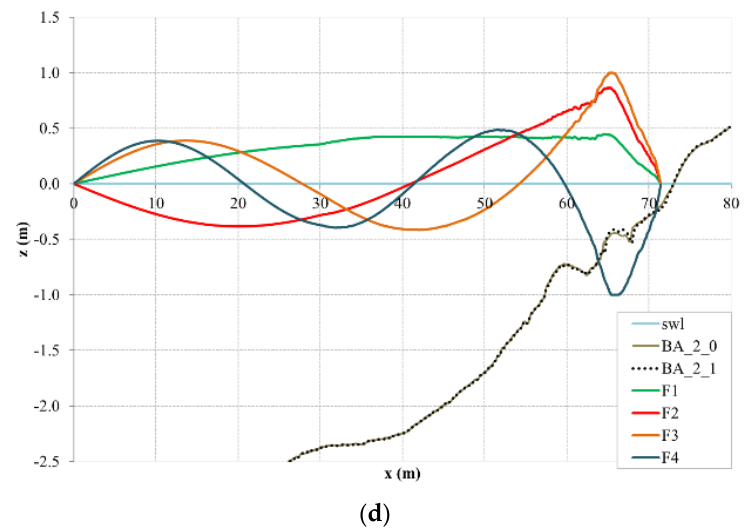
Figure 7. Eigenmodes for volume flux q related to the profile measured in bichromatic tests: ( a ) BE_1; ( b ) BE_2; ( c ) BA_1 and ( d ) BA_2.